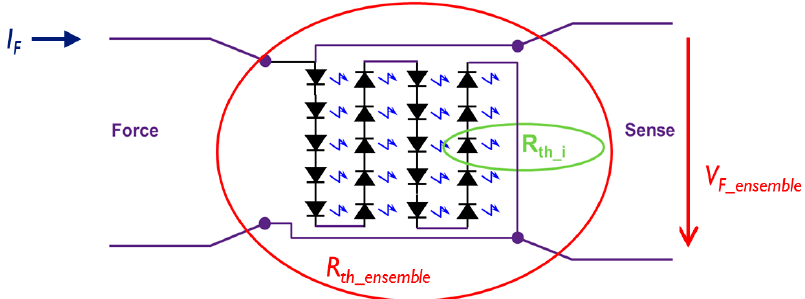
Figure 5. Illustration of the ‘ensemble’ thermal resistance and forward voltage of a serially connected LED array (as per Figure 4a) in the powering/measurement scheme recommended by the JEDEC JESD 51-51 standard [36] for thermal testing. For the explanation of symbols used in this figure see the main text and the Appendix.